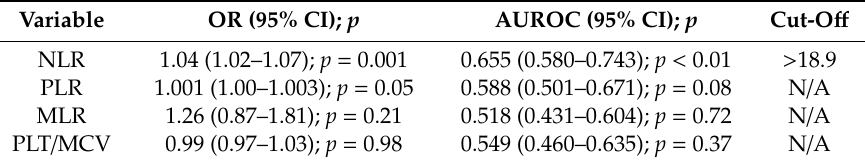
Table 4. Septic shock prediction by investigated indices in bivariate analyses.